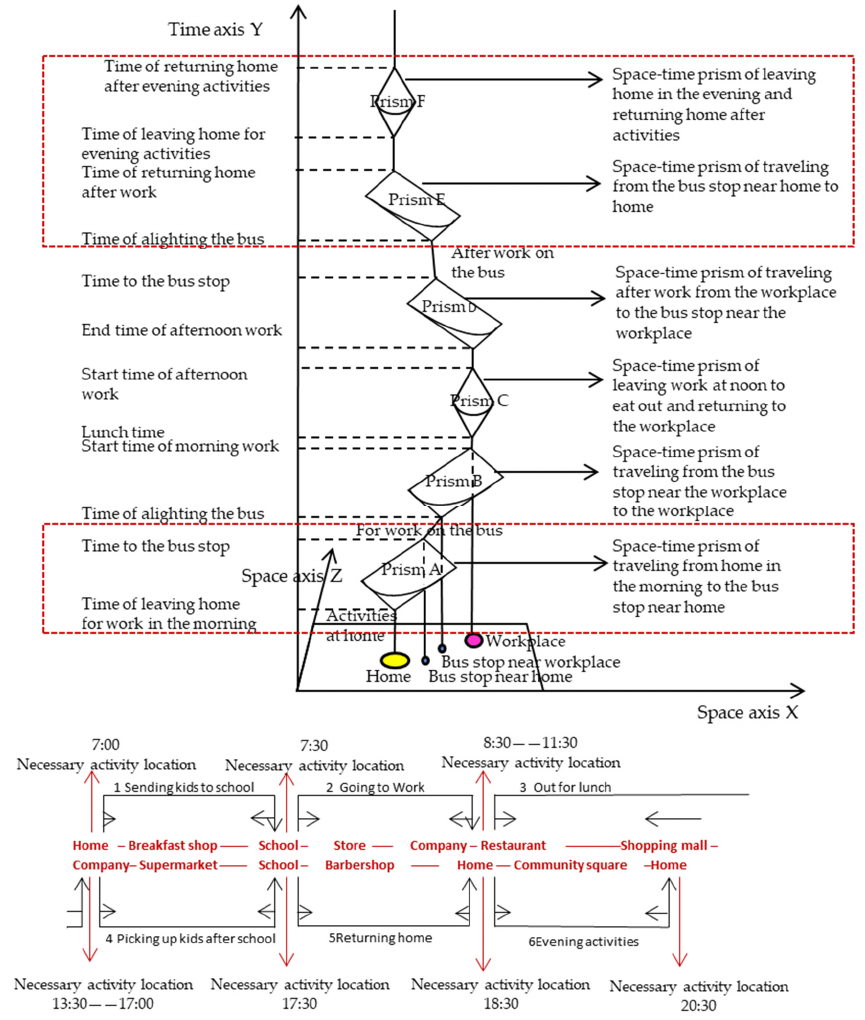
Figure 4. Space-time prism of commuting by bus on workdays.